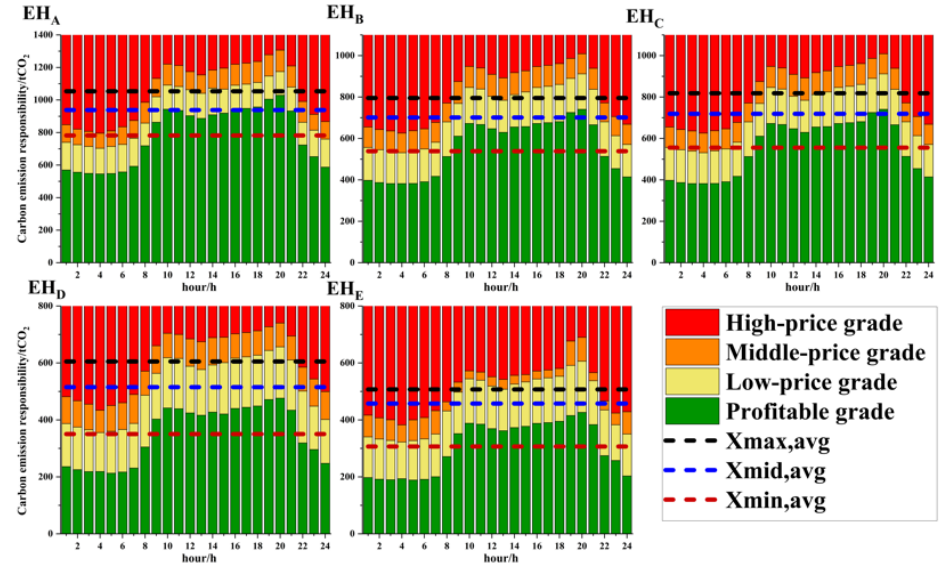
Figure 7. The carbon emission responsibility grades of each EH allocated by the Shapley value in Scenario 1. Scenario